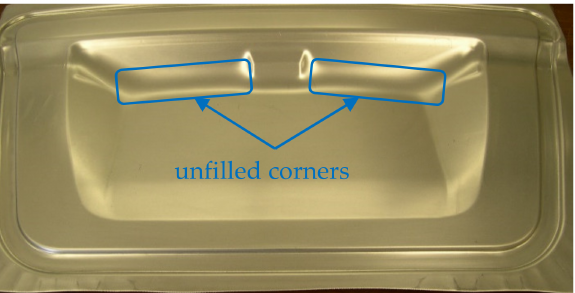
Figure 4. Aluminum 6111-T4 panel formed by quasistatic hydroforming using 2.1 MPa of pressure.